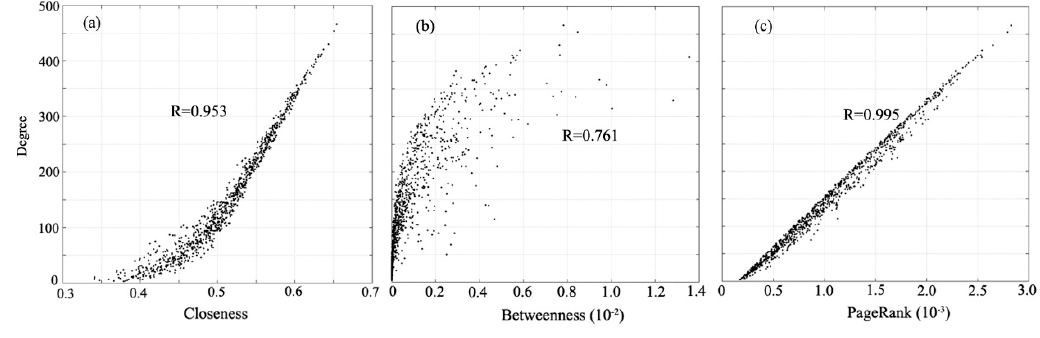
Figure 12. Correlation between degree and centrality.